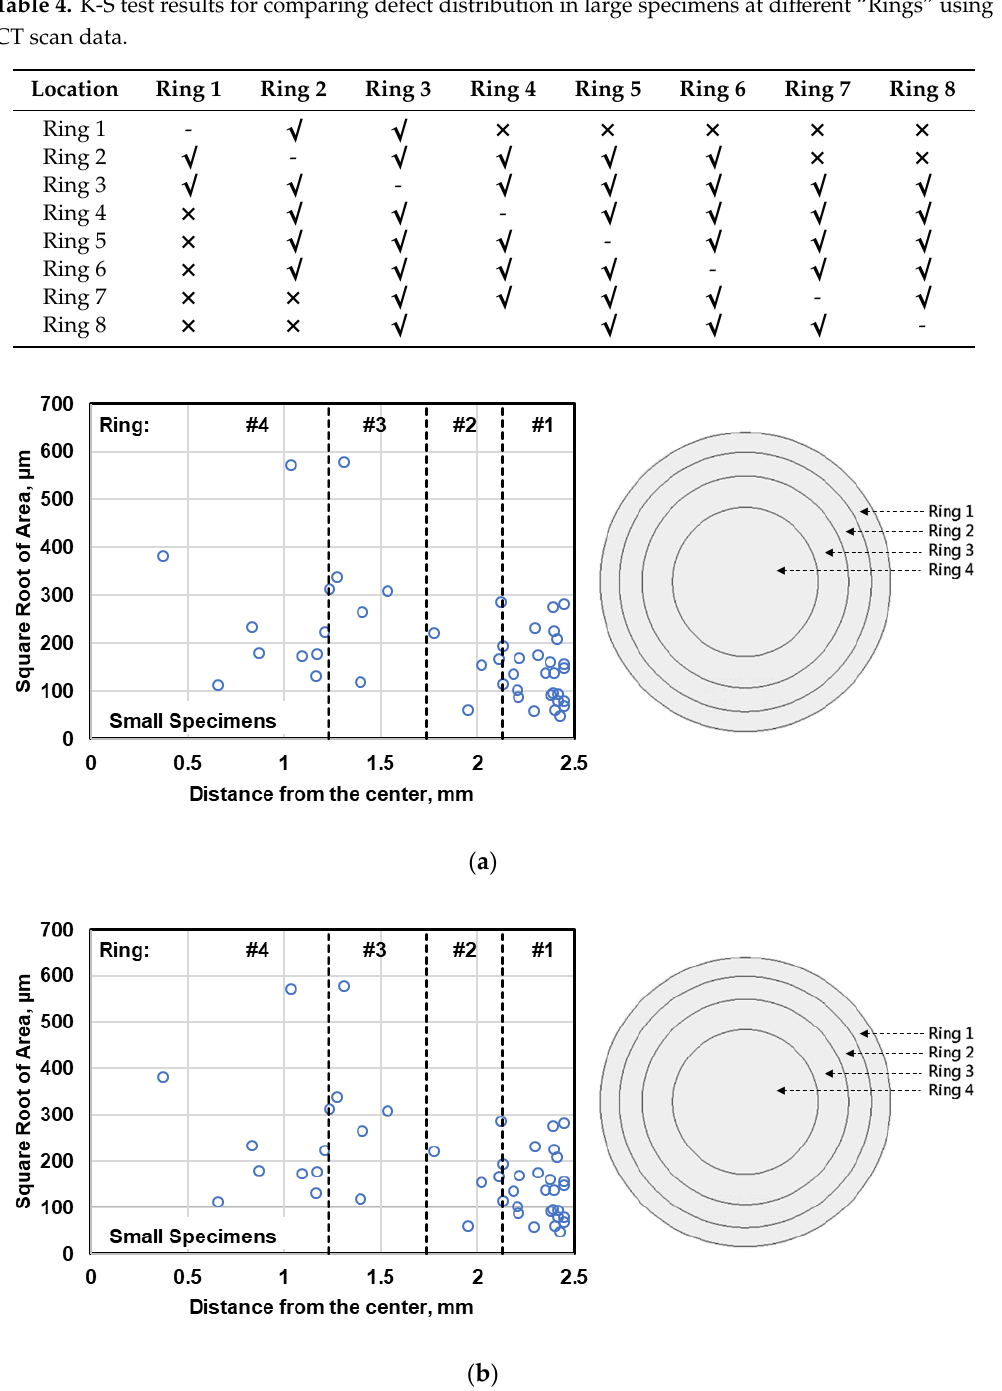
Figure 15. Comparison of the radial distribution of the fatal defects observed on fracture surfaces in terms of their distance from the center in ( a ) small and ( b ) large specimens.